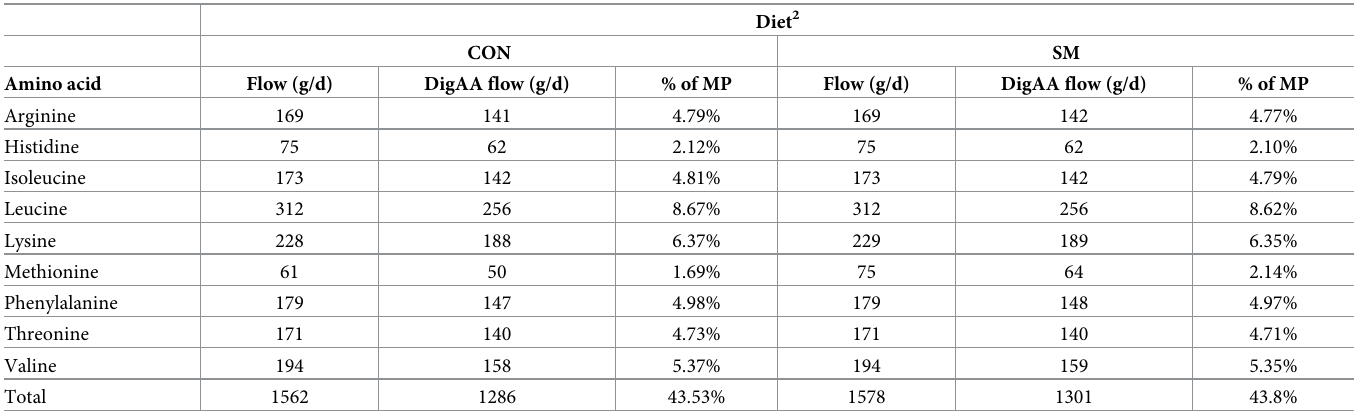
Table 2. Predicted flows of EAA to the small intestine (NRC, 2001) 1